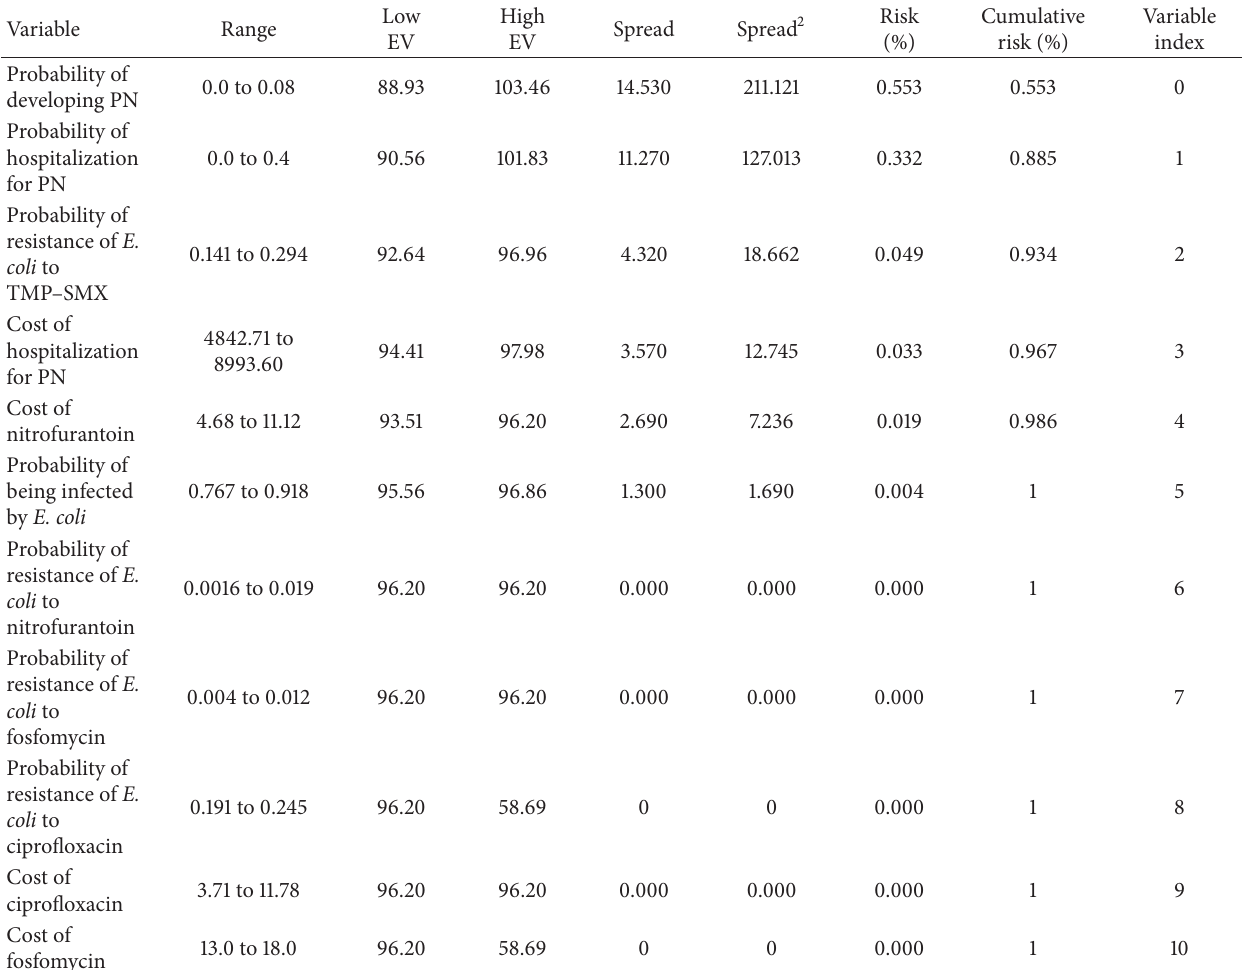
Table 3: Results of tornado diagram (decision